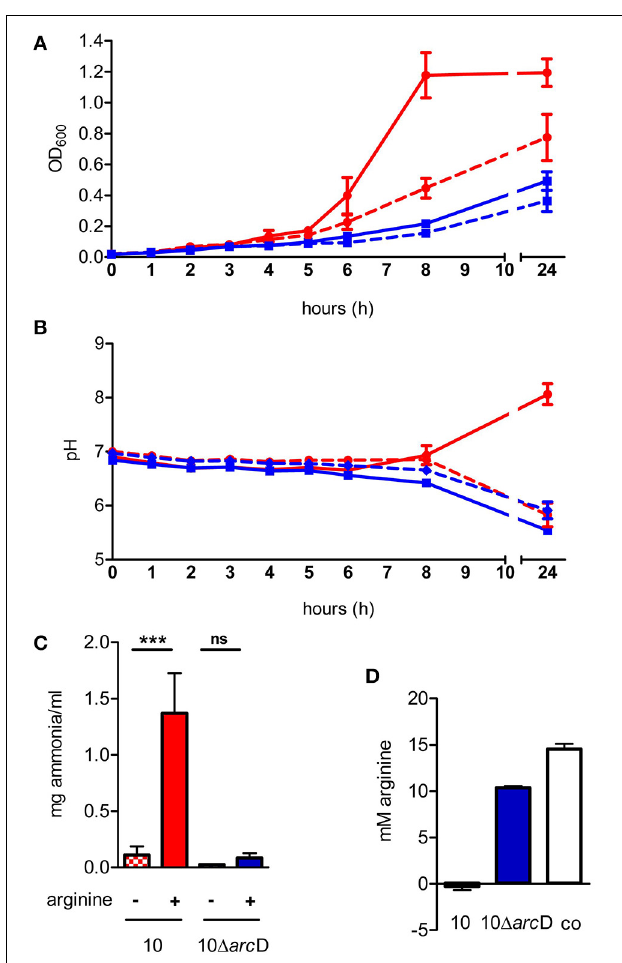
FIGURE 2 | The S. suis ArcD contributes to environmental pH homeostasis and biological fitness in an arginine-dependent manner. (A) Growth kinetics of S. suis WT strain 10 (red) and its isogenic arc D-deficient mutant strain 10 (cid:2) arc D (blue) in a tryptone-based medium containing 10mM galactose (dotted lines) and 50mM arginine (solid lines) if indicated. The optical density at 600nm OD 600 was measured every hour. Data represent means and standard deviations of a representative experiment performed in triplicates. Experiments were repeated at least two times. (B) Bacteria were grown as described in (A) , the course of pH values were measured every hour. Data represent means and standard deviations of a representative experiment performed in triplicates. Statistics were performed in a one-tailed t -test with p < 0 . 01. (C) Ammonia production of the culture supernatant was measured after 24h of growth. Results are given asmg ammonia per ml of medium (ml − 1 ). Statistical significance is indicated for a one-sided t -test ( ∗∗∗ p < 0.001; ns, not significant). (D) The amount of arginine in the culture supernatant of WT strain 10 (red bar) and 10 (cid:2) arc D (blue) was detected by a method adapted from Sakaguchi (1925). Results are given in mM arginine. TY medium alone (white bar) served as negative